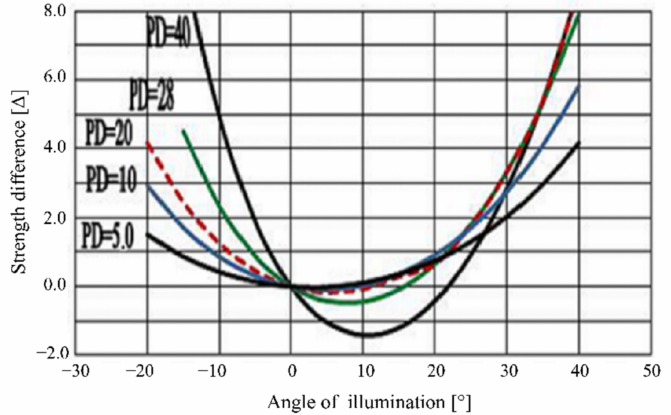
Figure 9. Dependence of prismatic diopter on the difference in rotating angle for prisms with different prismatic diopter (PD).